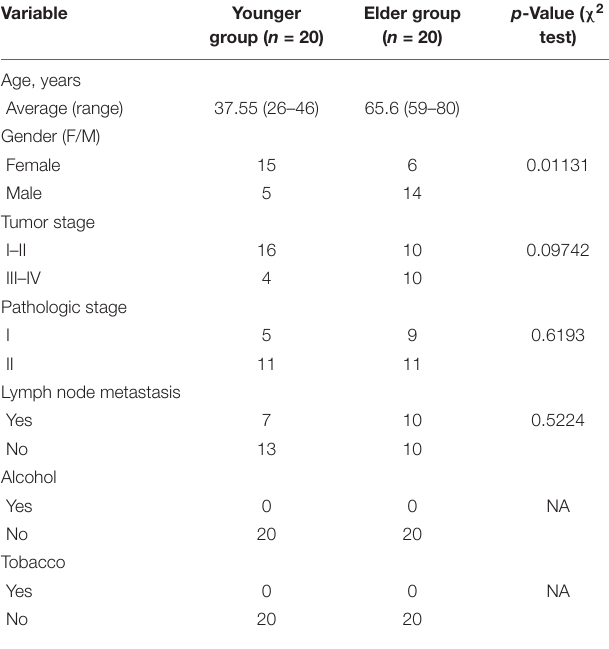
TABLE 1 | Demographic data of subjects enrolled in the